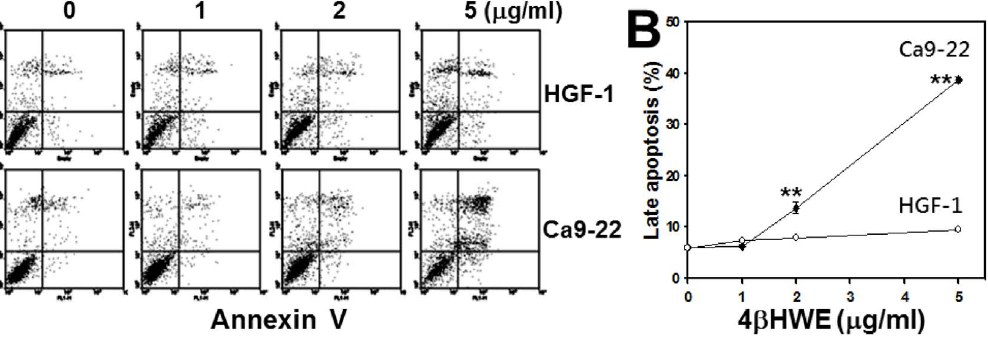
Figure 7. Treatment with 4 b HWE induced different apoptotic profiles in oral cancer Ca9-22 cells and in normal oral HGF-1 cells. Cells were treated with 0, 1, 2, and 5 m g/ml 4 b HWE for 24 h. (A) Representative apoptotic profiles obtained by Annexin V/PI double staining in 4 b HWE- treated Ca9-22 and HGF-1 cells. (B) Quantification analysis results for late apoptosis population (%). Only annexin V ( + )/PI ( + ) regions were analyzed. Data, mean 6 SD (n=3). Asterisks indicate statistically significant differences between two cell lines (Ca9-22 and HGF-1) treated with similar 4 b HWE concentrations ( t -test, P , 0.0001**).